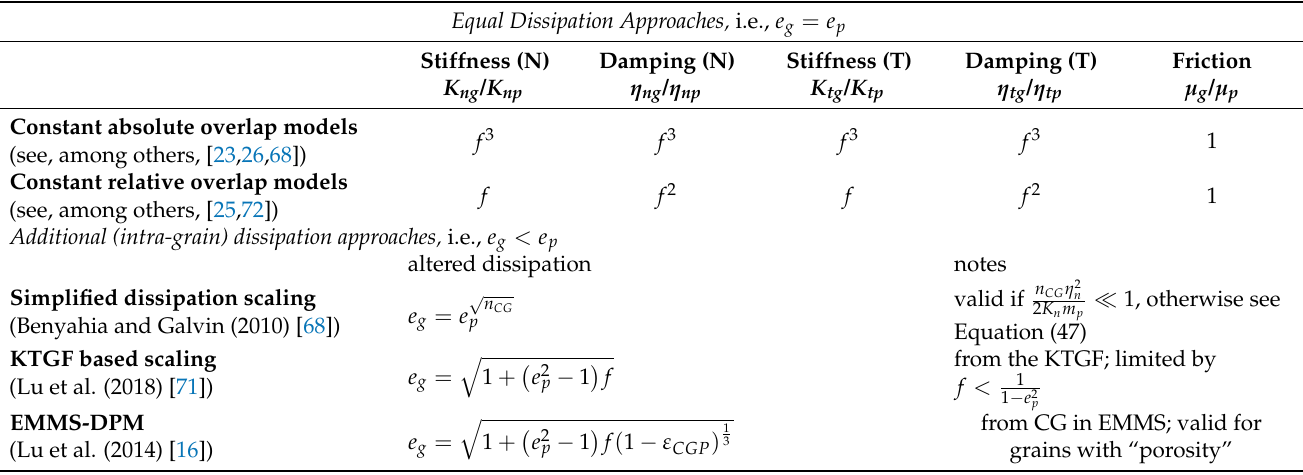
Table 2. Summary of the scaling factors for the linear spring-dashpot-slider model.